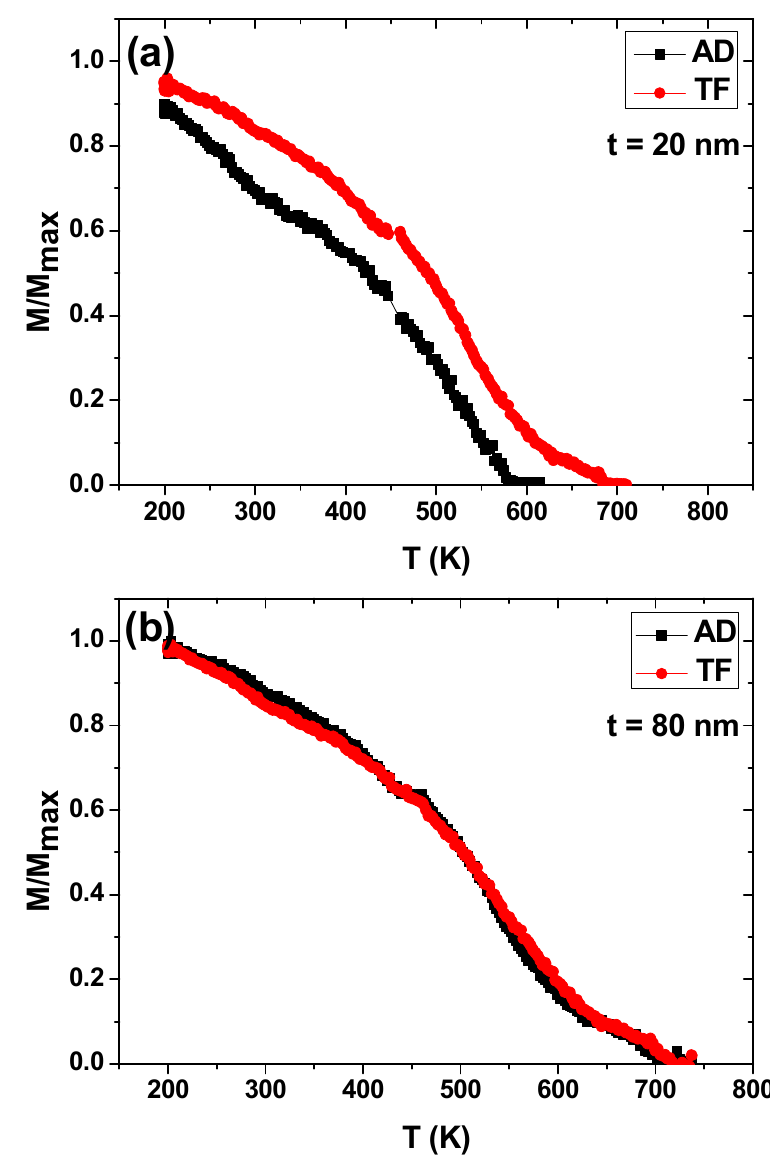
Figure 6. Temperature dependence of the normalized magnetization in Fe 70 Pd 30 alloys for both continuous Fe–Pd alloy thin film (CTF) and nanostructured array samples with layer thickness of ( a ) 20 nm and ( b ) 80 nm, measured at a constant applied field of 20 kOe along the in-plane direction.